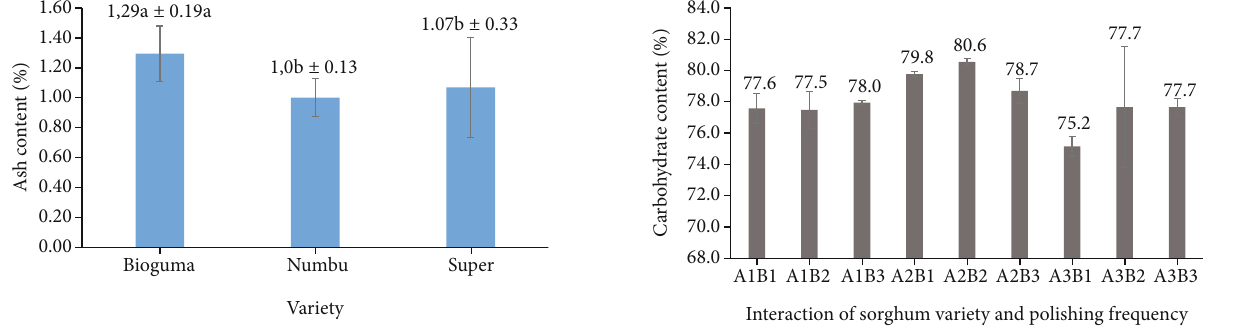
Figure 18: Carbohydrate content (by di ff erence) of three varieties of polished sorghum grains at di ff erent polishing frequencies.